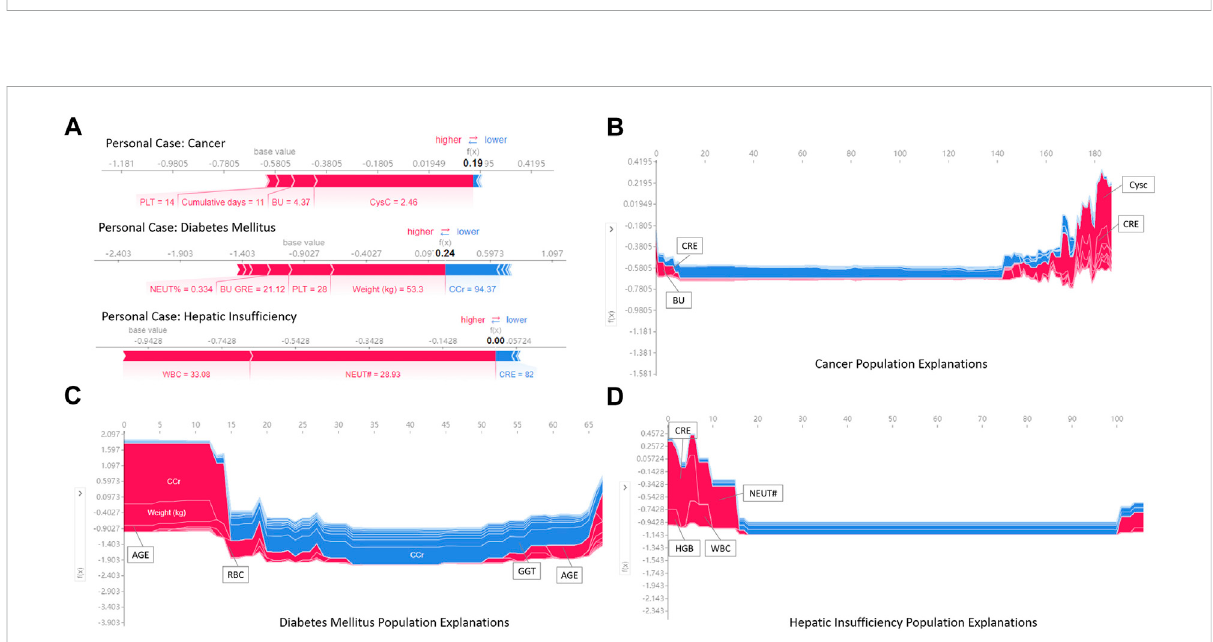
FIGURE 7 Examples of using SHAP values to explain the prediction results. The features pushing higher the predicted probability of AKI are shown in red, and those pushing the prediction lower are shown in blue. Additionally, the length of the bars corresponds to the contribution of each factor.